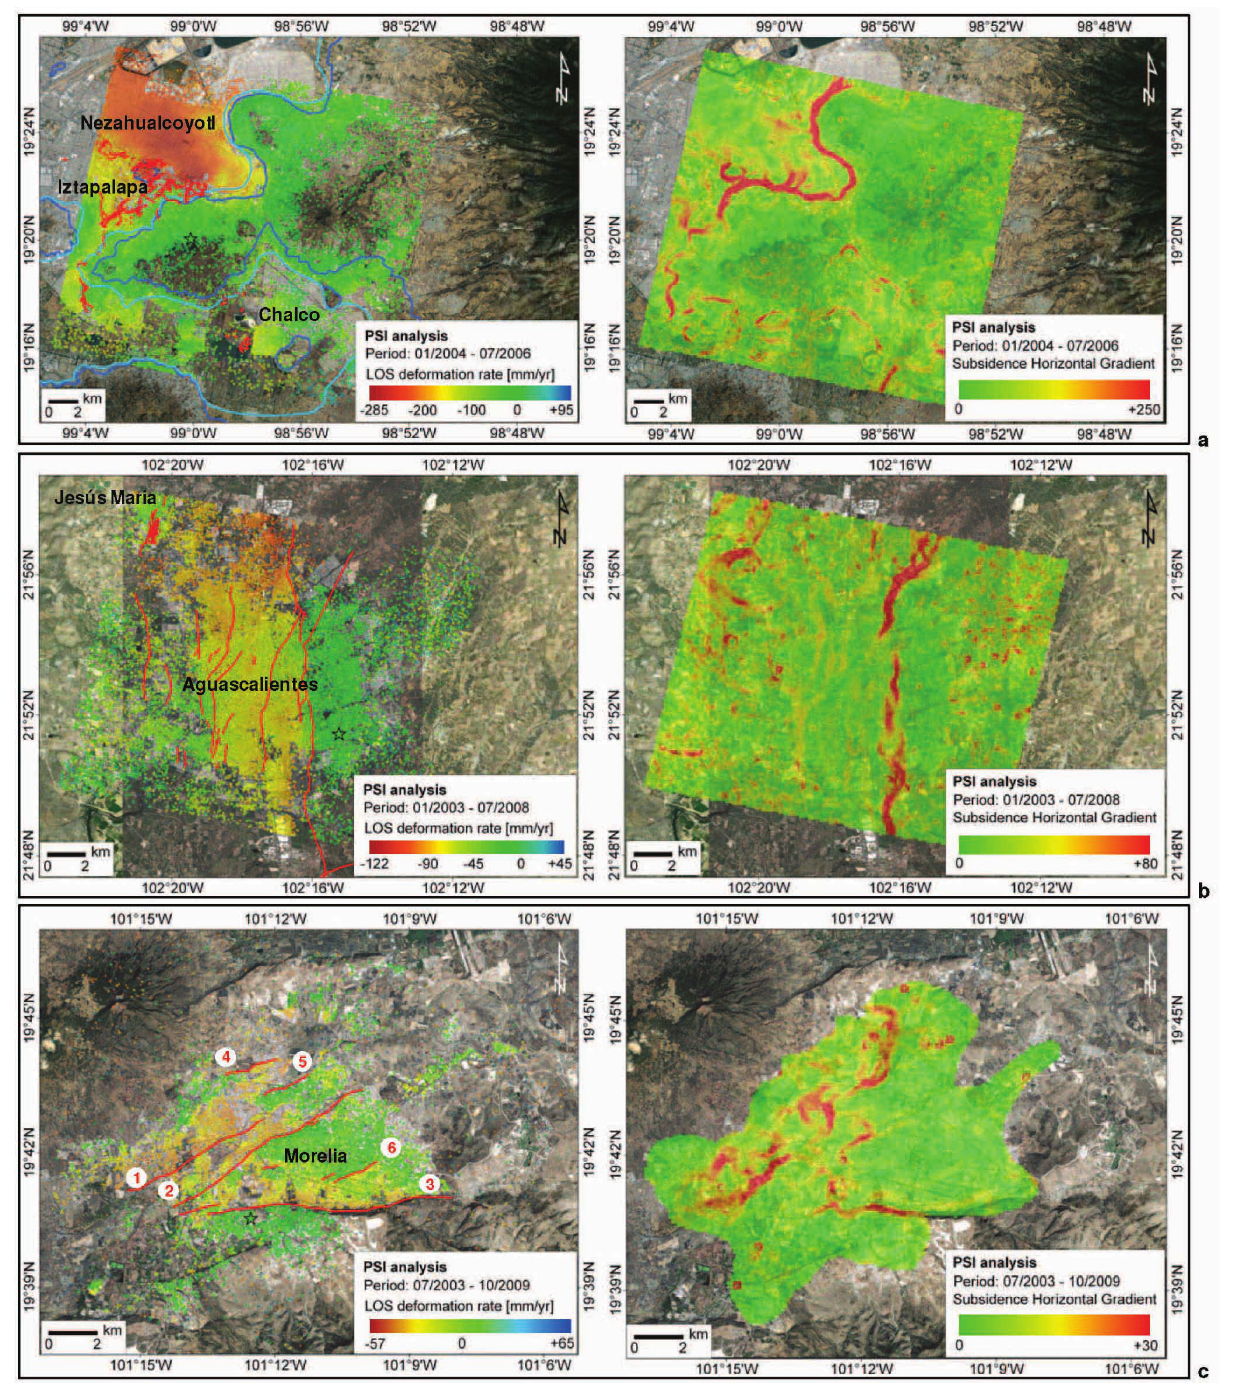
Figure 2. LOS deformation rates (left panels) and subsidence horizontal gradients (right panels) in the urban areas of Chalco (a) , Aguas- calientes (b) and Morelia (c) in Central Mexico, using ENVISAT 2004–2006, 2003–2008 and 2003–2009 data, respectively (after Cigna et al., 2011). Red lines show mapped faults. The geotechnical zonation of Chalco (a) shows the boundaries of lacustrine (light blue lines) and transitional (blue lines) geotechnical units. InSAR derived ground subsidence velocity maps (left panels) were processed using a horizontal subsidence gradient analysis approach that provides an excellent tool to discriminate areas with high potential of surface faulting (right panels). Notice the close correspondence between mapped faults on the corresponding left panels and the high gradient areas shown on the left panels. Further data merging with population, hydrology and meteorology data sets allow the creation of risk maps using a simple risk matrix (see Fig.